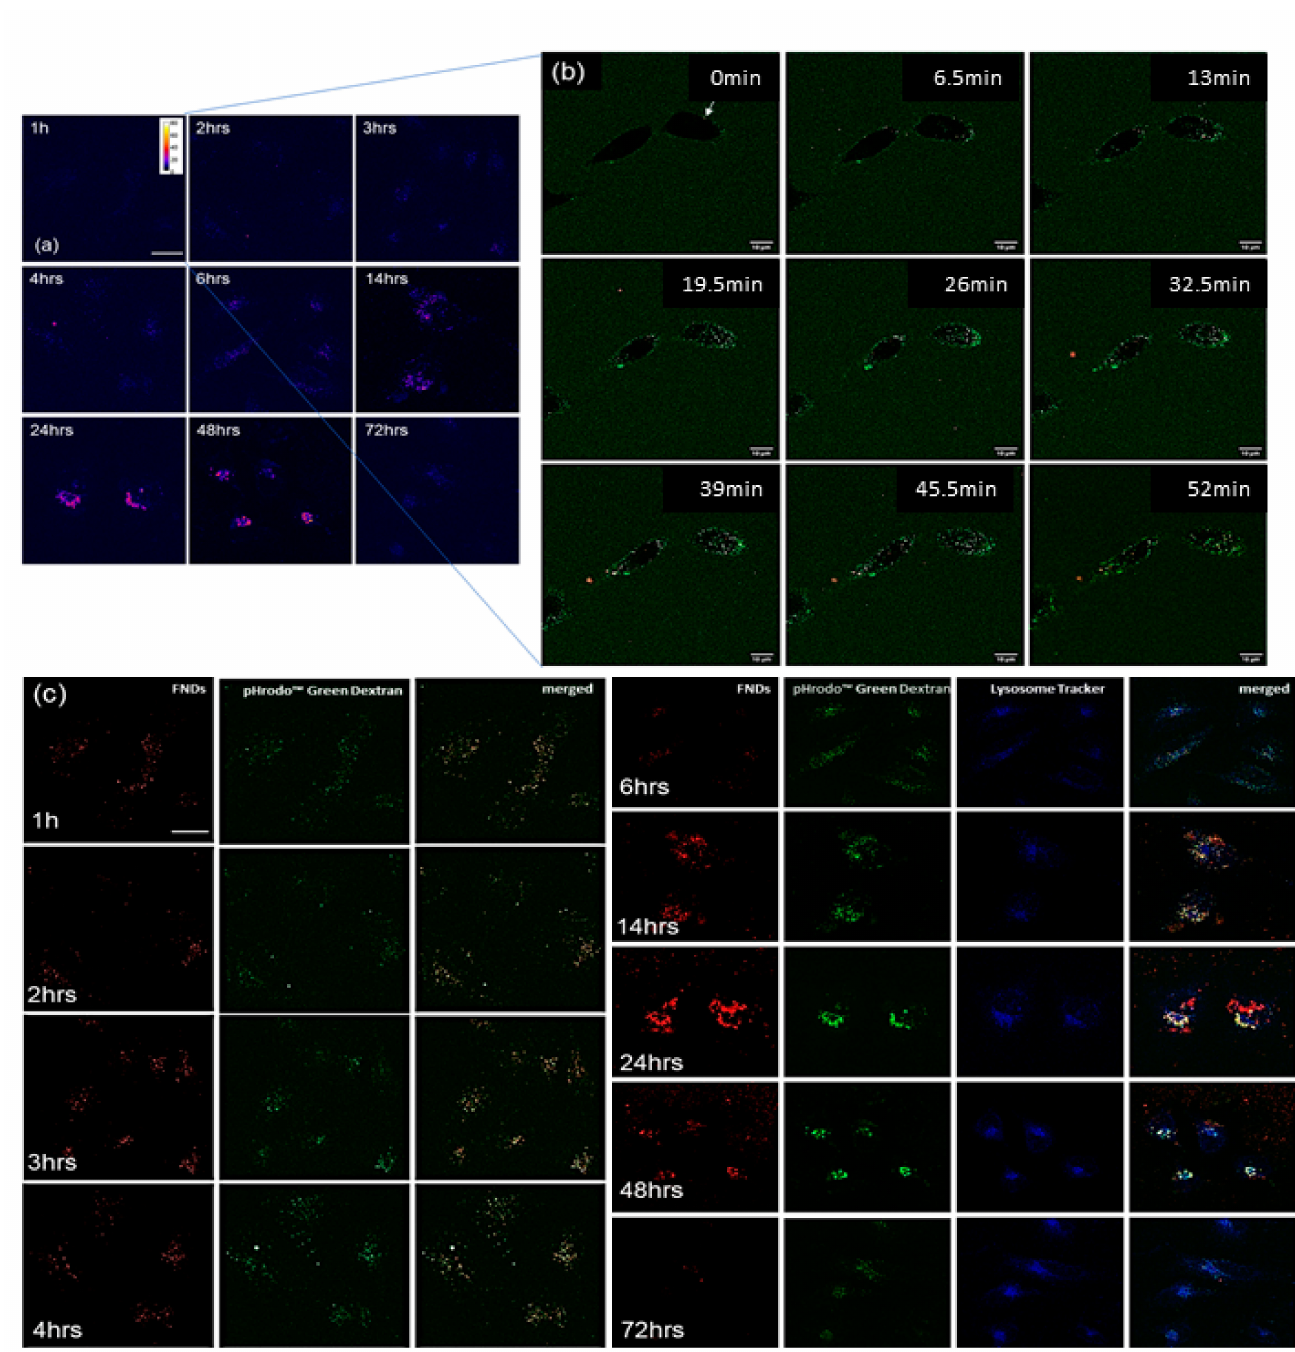
Figure 5. Intracellular location of FNDs in HeLa cells. ( a ) Confocal images of pHrodo Green Dextran adsorbed FNDs incubated with cells for different times. Signals of pHrodo Green Dextran and FNDs are shown in blue using a Fire lookup table in FIJI to investigate the strength of fluorescent intensity changes based on pH changes inside cells. The scale bar is 20 µ m. ( b ) Confocal images after 1 h after entry of pHrodo Green Dextran adsorbed FNDs to cells. Bright dots in cells are pHrodo Green Dextran adsorbed FNDs, scale bar 10 µ m. Arrows are used to highlight diamond particles. ( c ) Subcellular location of pHrodo Green Dextran adsorbed FNDs. Green: pHrodo Green Dextran, red: FNDs, blue: LysoTracker (Lysoview 405, lysosome tracker), scale bar 20 µ